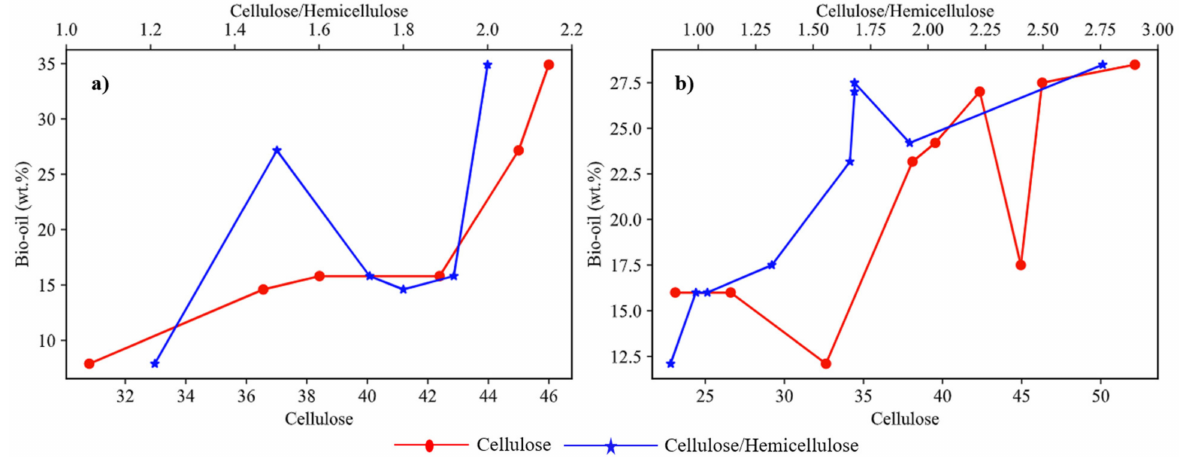
Figure 3. Effect of cellulose and cellulose/hemicellulose ratio on bio-oil yield for ( a ) agricultural feedstocks [23–28], ( b ) forest feedstock